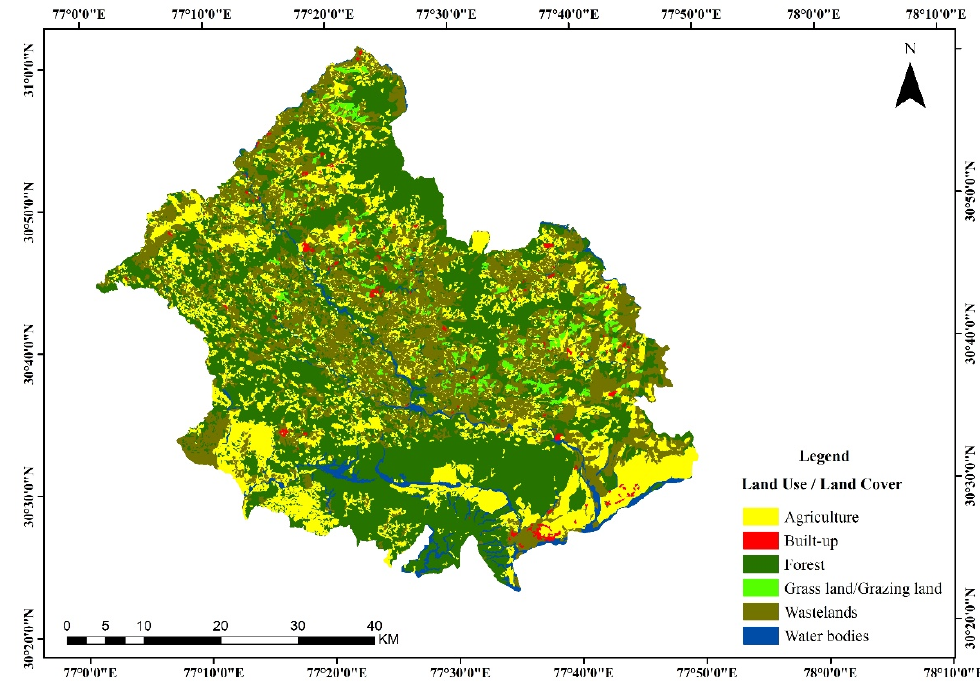
Figure 10. Land use/land cover map.